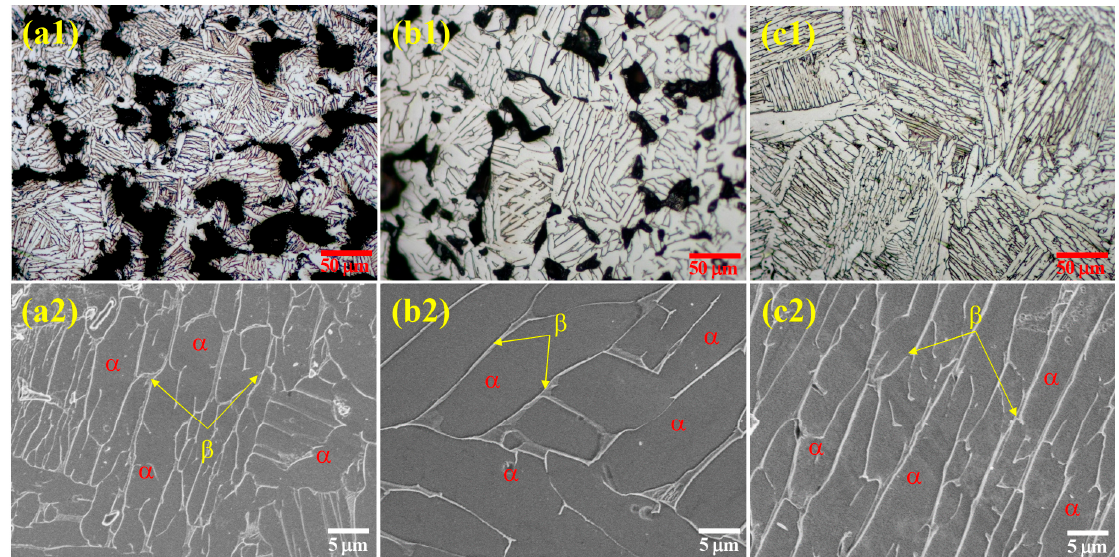
Figure 6. Microstructure of Ti6Al4V alloy sintered by di ff erent sintering techniques: ( a1 , a2 ) vacuum sintering, ( b1 , b2 ) capsule-free HIP, and ( c1 , c2 ) capsule HIP.